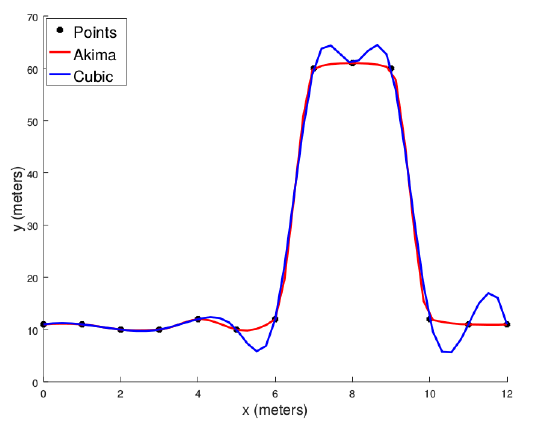
Figure 5. Comparison between Akima and cubic